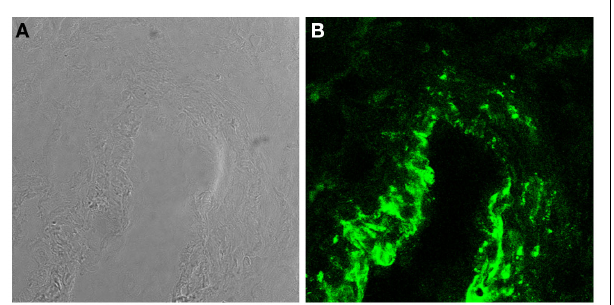
FIGURE 2 | C7 is synthesized and expressed by DECs. (A) Light microscopy image of a decidual vessel from human first trimester placenta. (B) Confocal analysis of the same decidual vessel stained for